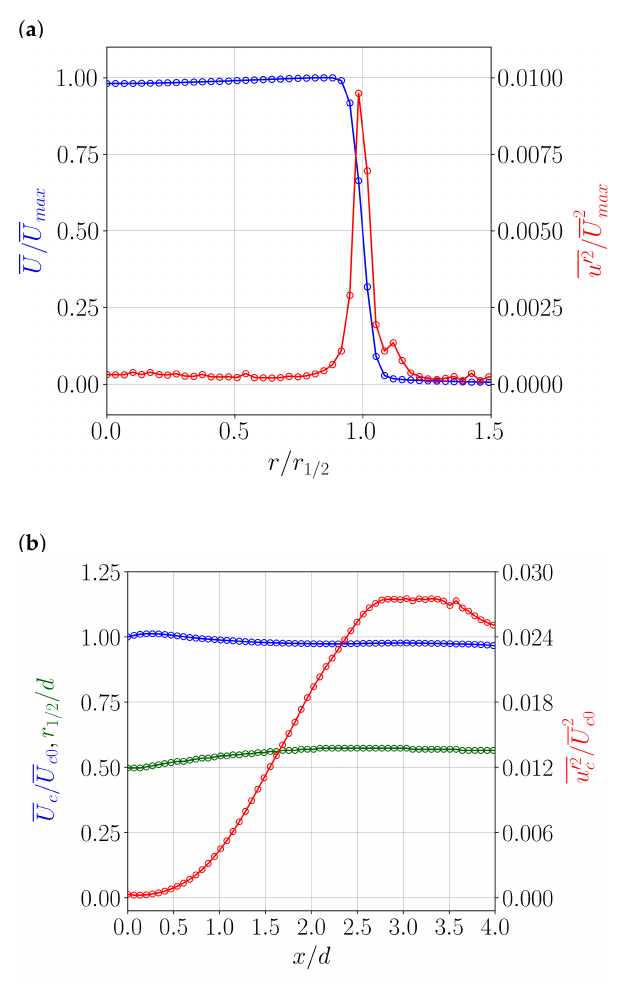
Figure 4. Jet flow characterisation: ( a ) mean axial velocity U / U max and axial component of the streamwise Reynolds stress u (cid:48) 2 / U 2 max at the jet exit; ( b ) axial variation of the jet centre-line mean axial velocity U c / U c0 , centre-line axial component of the streamwise Reynolds stress u (cid:48) 2 c / U 2 c0 , and the half width r 1/2 / d